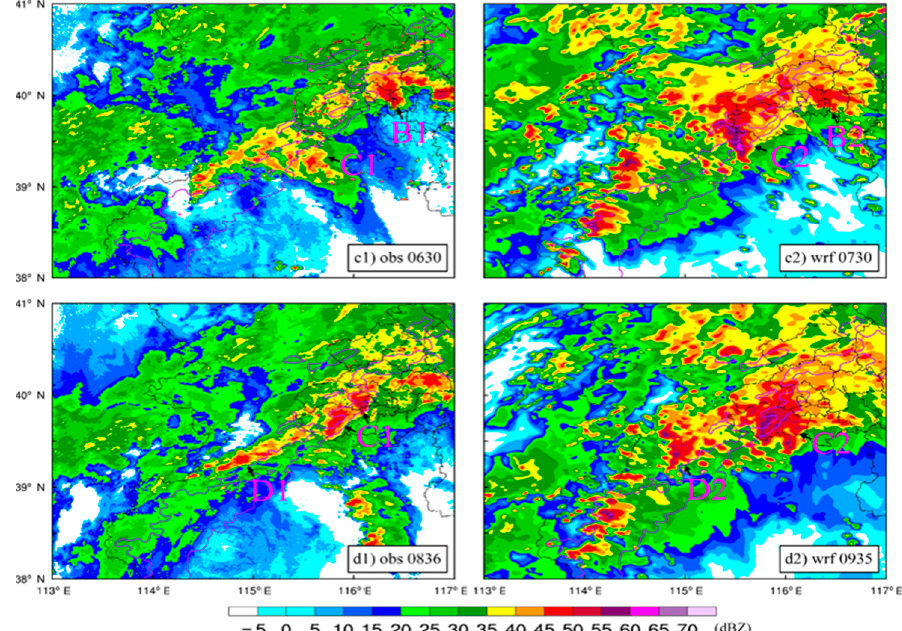
Figure 5. ( a1 – d1 ) Observed composite radar reflectivity (shaded, units: dBZ) at 0200, 0418, 0630, and 0836 UTC 21 July 2012, respectively. The black contours are terrain height (units: m). ( a2 – d2 ) As in ( a1 – d1 ) but for the simulated results, which are valid at 0300, 0500, 0730, and 0935 UTC 21 July 2012. The labels “A1/A2”, “B1/B2”, “C1/C2”, and “D1/D2” denote the four main mesoscale convective systems (MCSs) (A, B, C, and D), respectively.